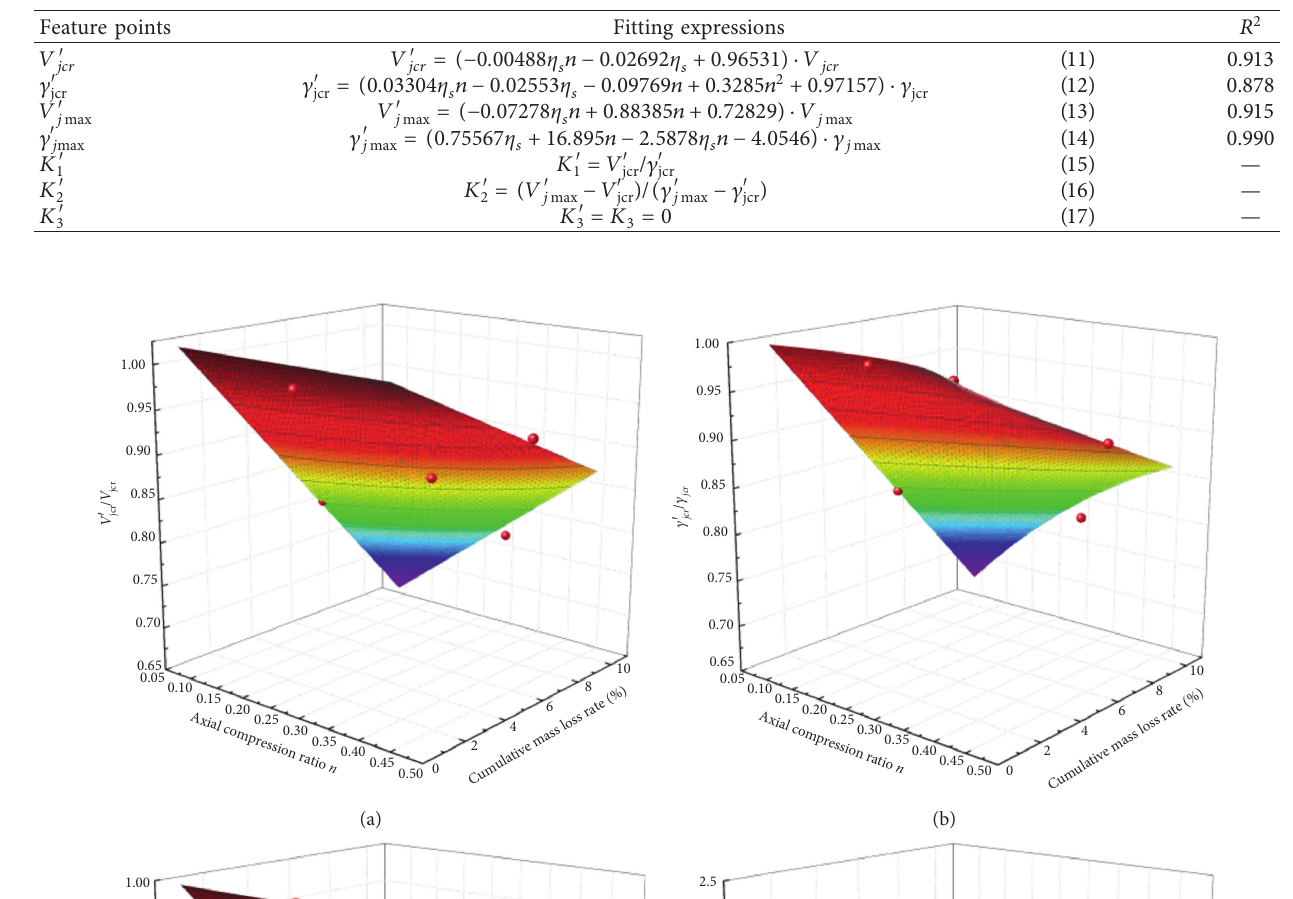
Table 7: Corrosion member feature point formulas.